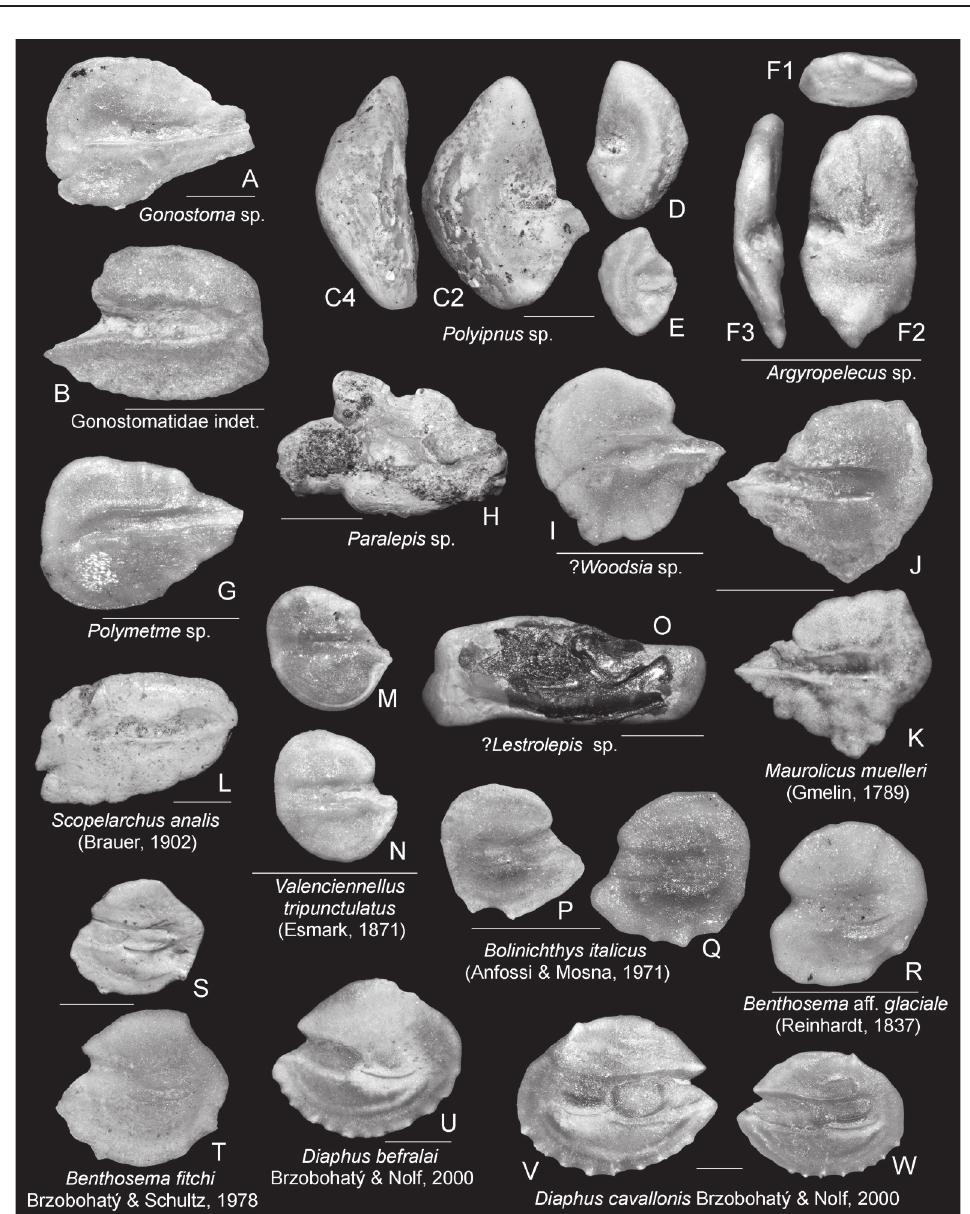
Fig. 4. Tortonian fish otoliths from northern Italy. A . G onostoma sp., Costa Vescovato (IRSNB